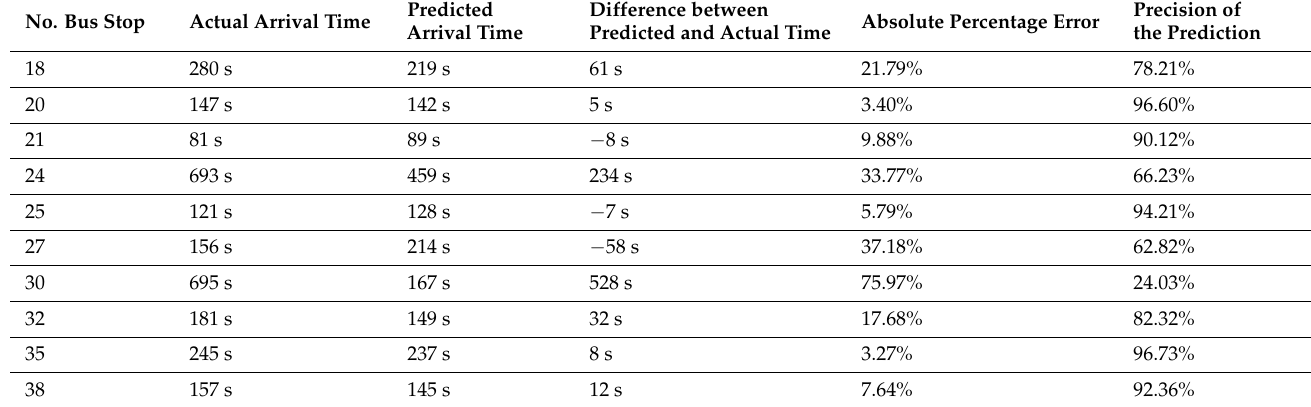
Table 2. Results obtained for Trip 2, Journey: University–Guacamayas. MAPE = 21.6% Precision = 78.4%.